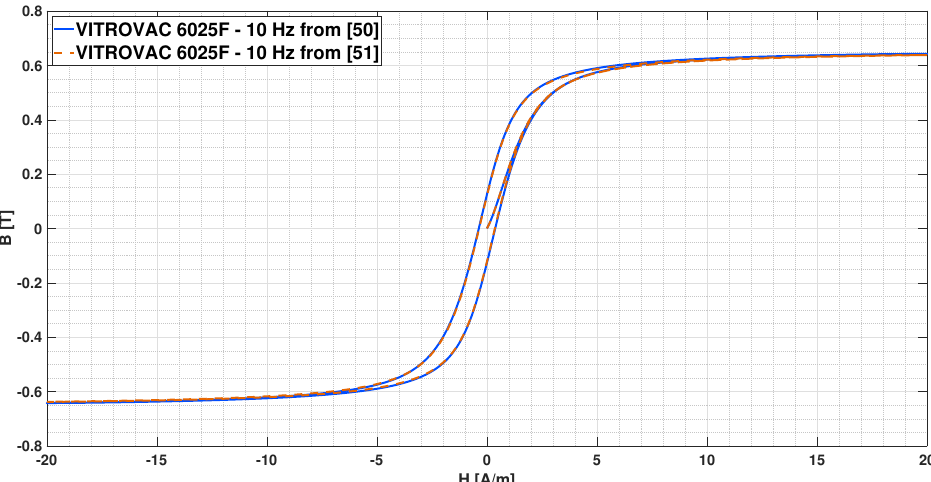
Figure 4. Hysteresis loops reconstructed from the two sets of Jiles–Atherton parameters reported in Table 1: continuous blue line from [52] and dashed orange line from [53], respectively.